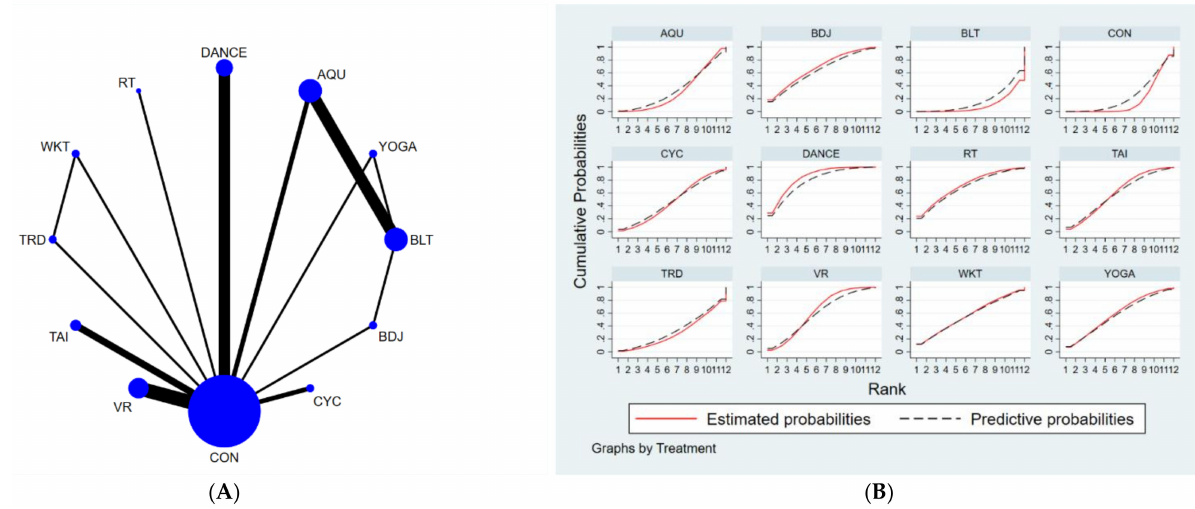
Figure 4. ( A ) NMA figure for BBS, ( B ) SUCRA plot for